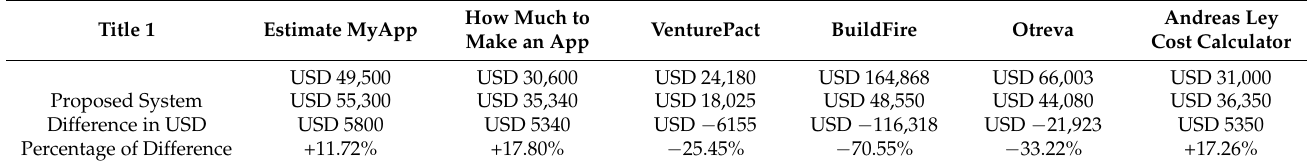
Table 3. Percentage and difference in terms of cost